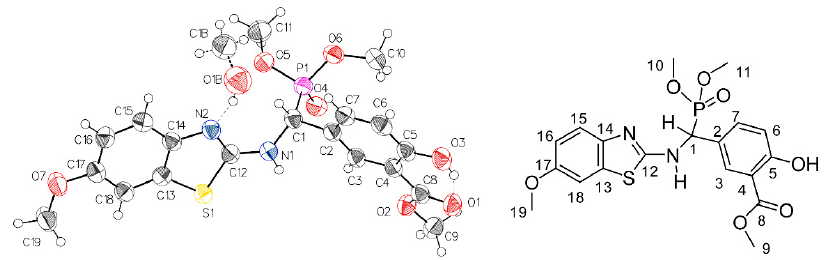
Figure 4. ORTEP diagram resulting from X-ray analysis of compound 2 . Methanol (CH 3 OH) was present in the crystal in a 1:2 proportion with compound 2 (represented as the R isomer).